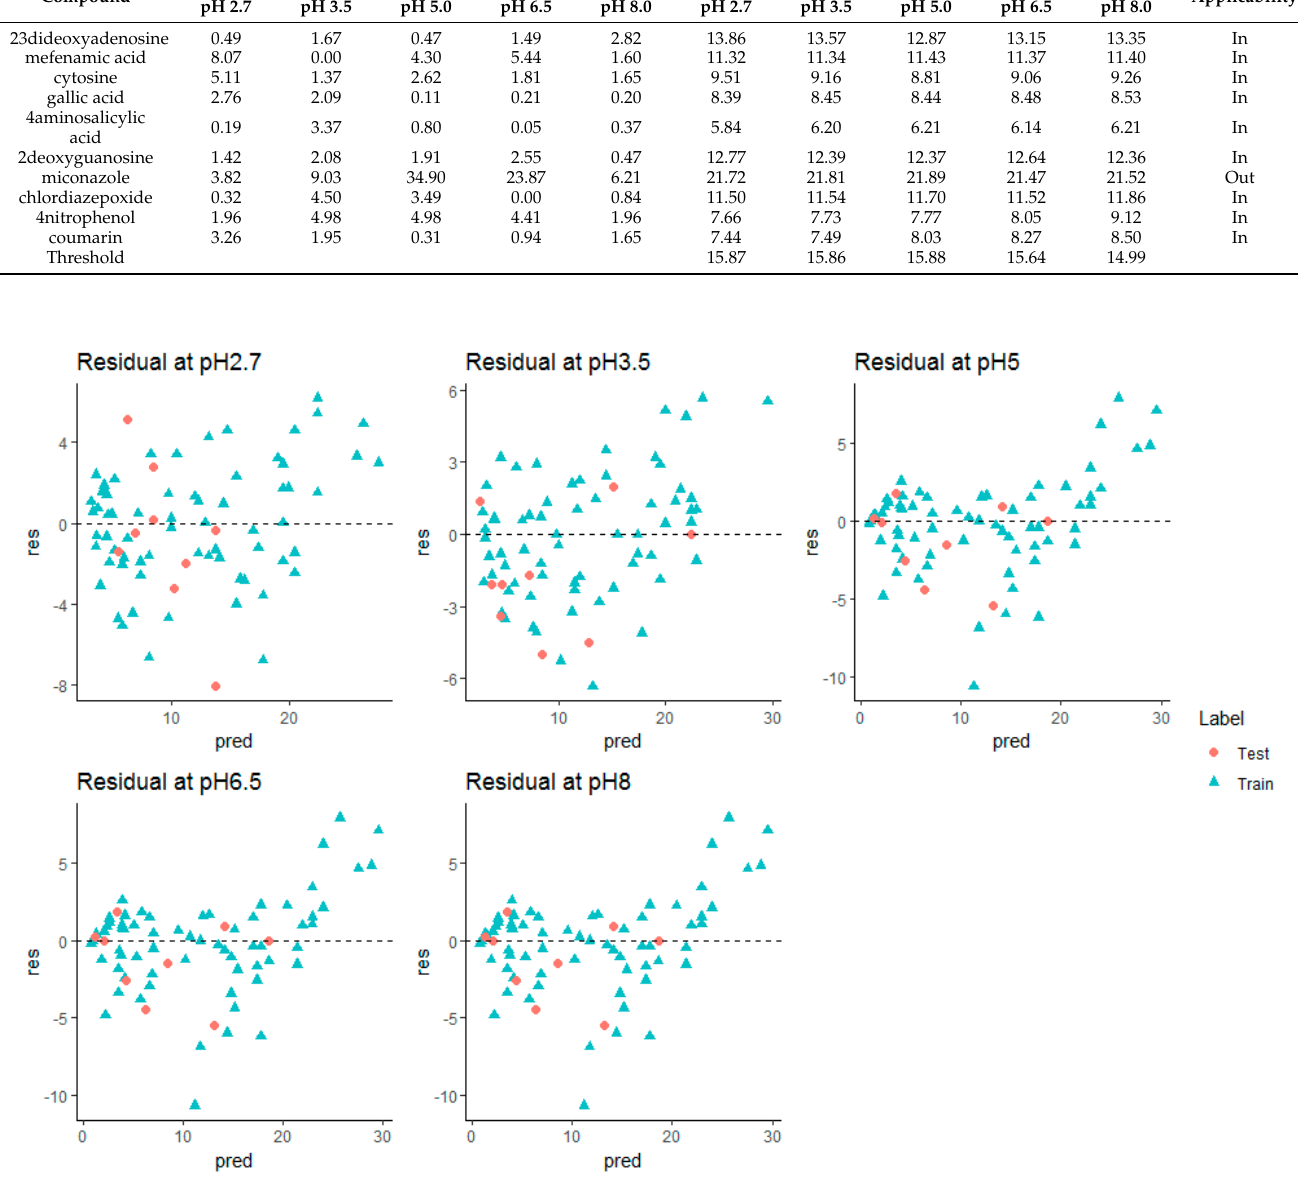
Figure 5. Residual plots (in min.) for stacking model at all pH (without miconazole).